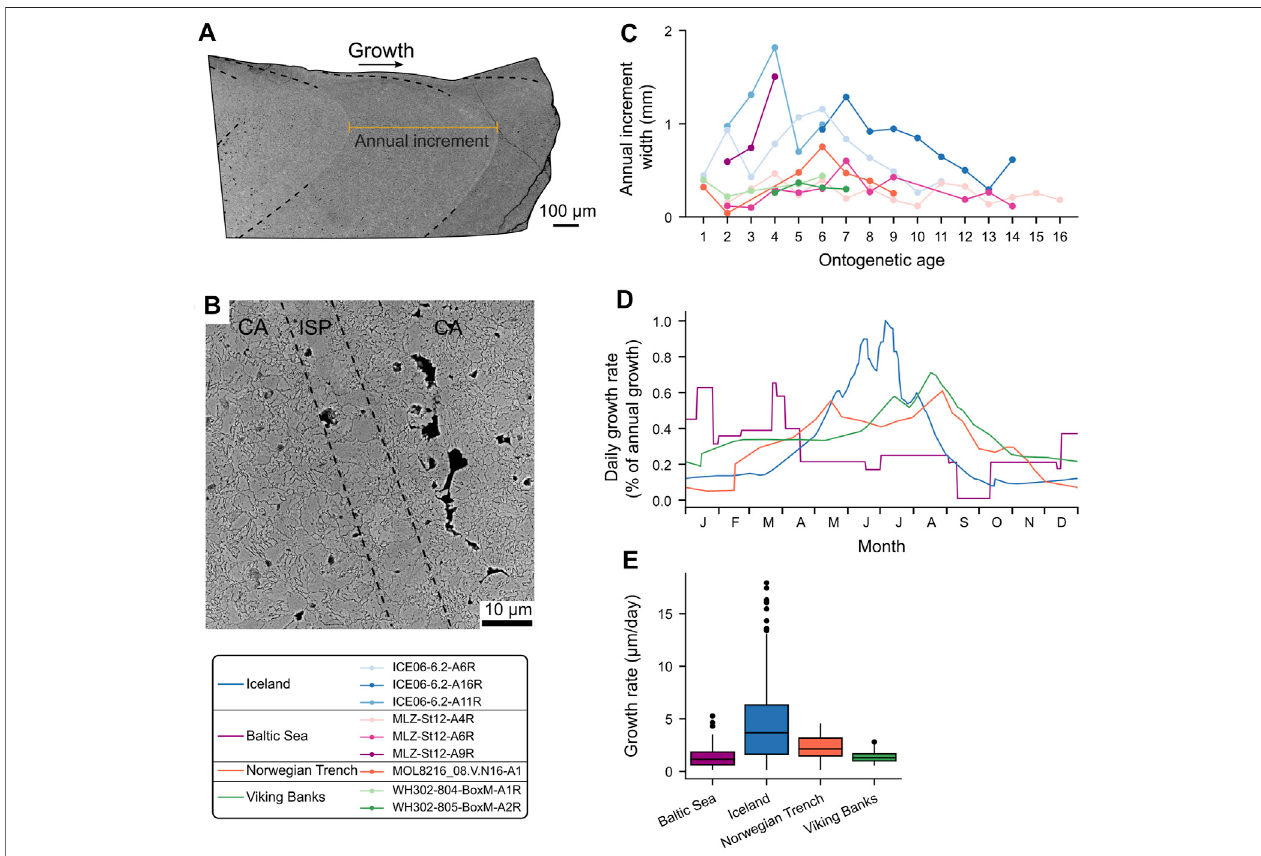
FIGURE 3 | Hinge plate of Arctica islandica . (A) Overview of a hinge plate showing the growth direction, annual growth lines (dashed lines) and annual increment (orange). (B) Magni fi ed annual growth line (SEM) showing the typical irregular simple prismatic (ISP) microstructure and the decrease in BMU size in the following crossed-acicular (CA) microstructures. Direction of growth is from lower left to upper right. (C) Annual growth increment curves of the studied specimens. (D) Seasonal growthmodels(dailyresolution)forthestudiedsitesbasedonthe δ 18 O shell alignmenttechnique( SupplementaryTableS1 ).ModelfortheBalticSeawasobtained from Schöne et al. (2021). (E) Daily shell growth rates of A. islandica at the different study